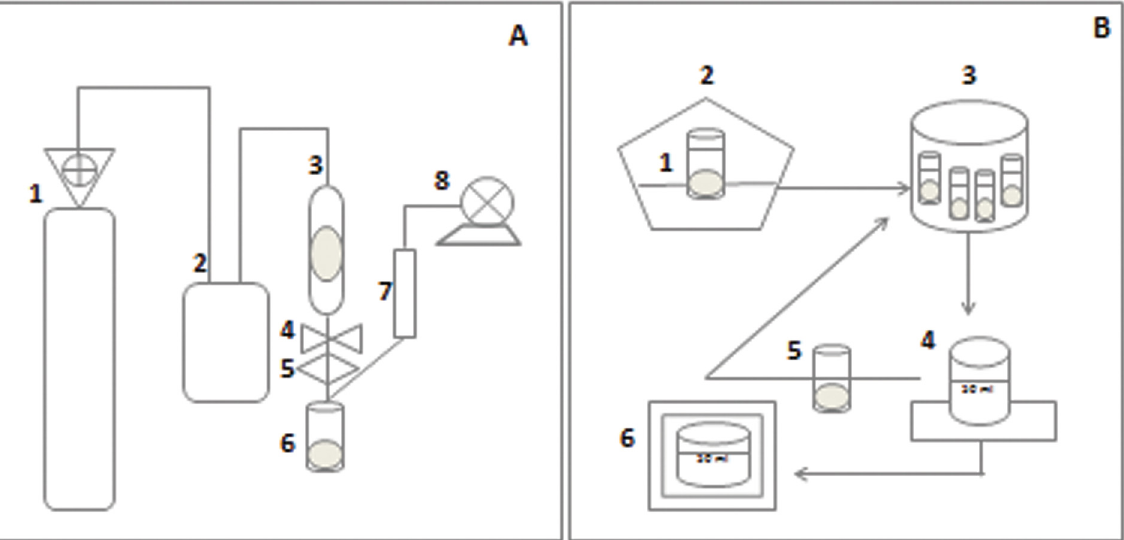
Fig 1. Extraction Process Stages. (A) High pressure extraction (SFE) 1 – CO 2 cylinder with fishing tube; 2 – Adjusted bomb at 350bar; 3 – Extraction cell using 7.5 g of sample (packed) and co-solvent at 50°C (furnace temperature); 4 – Static/dynamics valve; 5 – Restrictor valve adjusted to 6g/min CO 2 flow; 6 – Extracts into a collection bottle; 7 – Flow meter; 8 – Gas meter; (B) Low pressure extraction (conventional extraction) 1 – Propolis sample in ethanol (80%); 2 – Process extraction in a shaker (70°C, 30 minutes, 710rpm); 3 – Centrifugation at 8800rpm for 11 minutes at 5°C; 4 – Supernatant, centrifugation was repeated with the residue (10 ml of 80% ethanol); 6 – Homogenised supernatants and kept at 50°C until completely